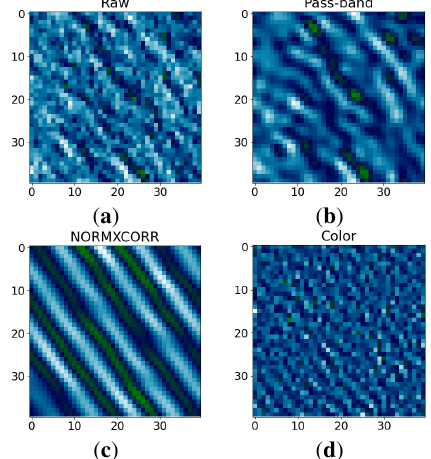
Figure 1. Pre-processing of a single 400 × 400 m Sentinel-2 subtile band (10 m resolution). ( a ) Raw subtile. ( b ) Passband-filtered subtile. ( c ) Final NORMXCORR result used as input to W-DSPEB. ( d ) Color-augmented subtile.